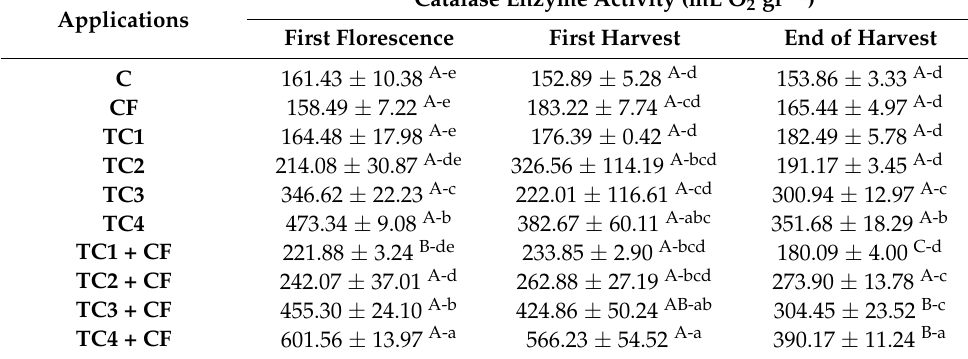
Table 7. Catalase enzyme activity